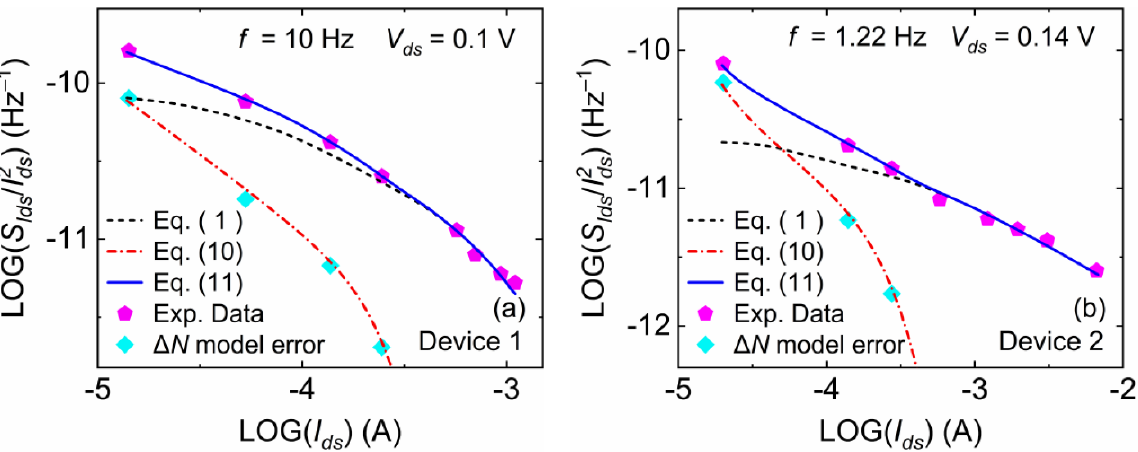
Figure 4. Plots of LOG( S Ids / I ds 2 ) versus LOG( I ds ) for ( a ) Device 1 and ( b ) Device 2. The experimental data in both 4H-SiC MOSFETs are represented by symbols, and the model results are represented by lines.